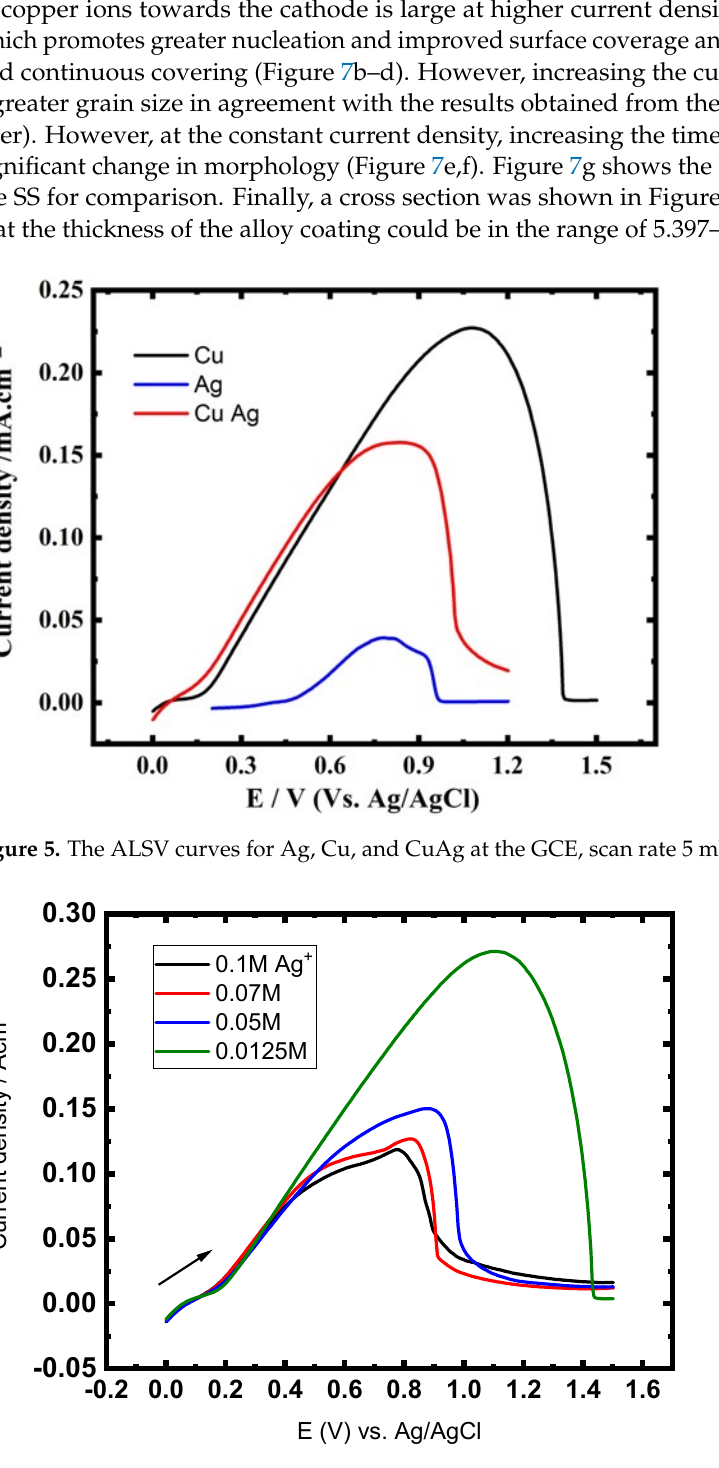
Figure 6. The ALSV recorded at GCE for CuAg with constant Cu 2+ ion concentrations and varying Ag + ion concentrations.